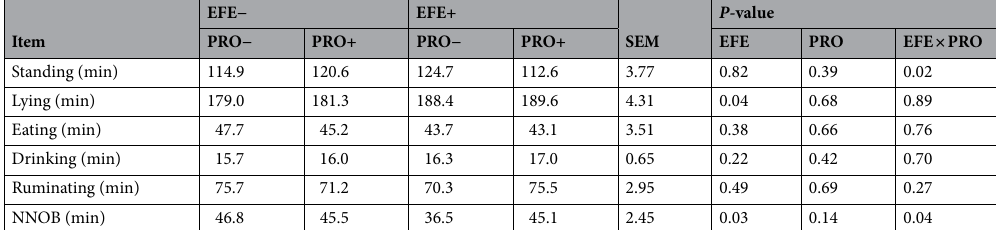
Table 5. Least squares means for behavior in dairy calves supplemented with or without exogenous fibrolytic enzymes (EFE) and probiotic (PRO) in the starter diets (n = 12 calves per treatment). Treatments were (1) calves fed diets without exogenous fibrolytic enzymes (EFE)-treated wheat straw and probiotic supplement (EFE-Pro−), (2) calves fed diets of EFE-treated wheat straw but with probiotic supplement (2 g/d/calf; EFE- Pro+), (3) calves fed EFE-treated wheat straw (2 g/d/calf) but without probiotic supplement (EFE+ Pro−), (4) calves fed EFE-treated wheat straw and probiotic supplement (EFE+ Pro+). Exogenous fibrolytic enzymes were applied to wheat straw. NNOB non-nutritive oral behavior.